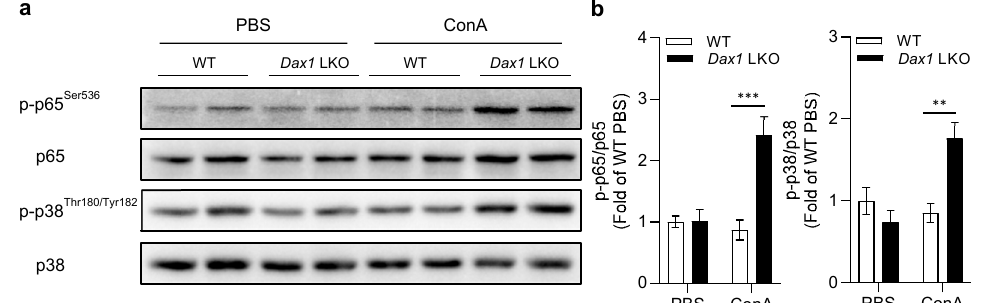
Figure 6. Phosphorylation of NF- κ B p65 is increased in ConA-treated Dax1 LKO mice liver. WT and Dax1 LKO mice were treated with a single administration of ConA (15 mg/kg, i.v.) or PBS. The liver samples were isolated at 6 h (WT + PBS; n = 5, LKO + PBS; n = 7, ConA; n = 6) post treatment. ( a ) The protein levels of p-p65, p65, p-p38, and p38 were determined using Western blot analysis, and ( b ) the phosphorylated p65 and p38 were quantified and normalized with their respective total p65 and p38 levels. Data are expressed as the mean ± SEM. Tukey–Kramer test after the one-way ANOVA was used to compare the ConA-treated LKO and ConA-treated WT groups; ** p < 0.01 and *** p <